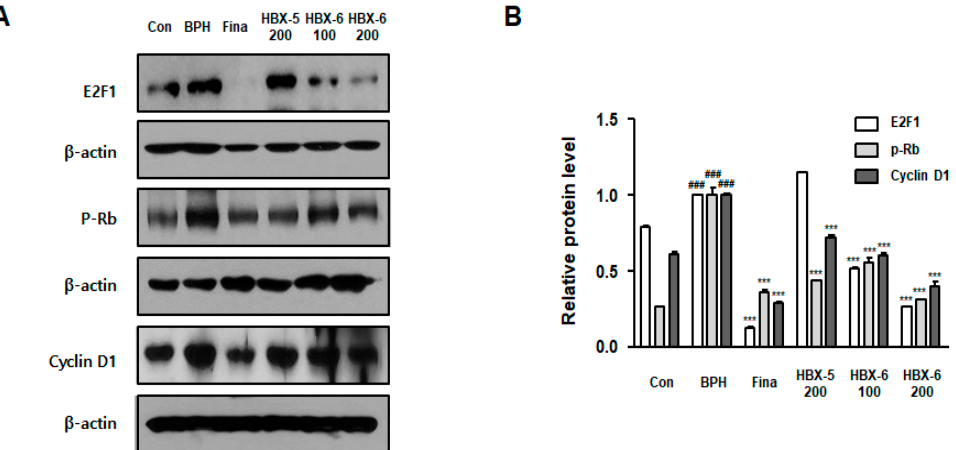
Figure 8. Effect of HBX-6 on cell cycle related-protein expression in prostate tissues of mice with BPH. The levels of E2F1, p-Rb and Cyclin D1 were analyzed by a Western blot analysis. Values were presented as mean ± SD ( n = 10); ### p < 0.001 versus control group; *** p < 0.001 versus BPH group. ANOVA and Dunnett’s post hoc test were used for significances between each experimental group.